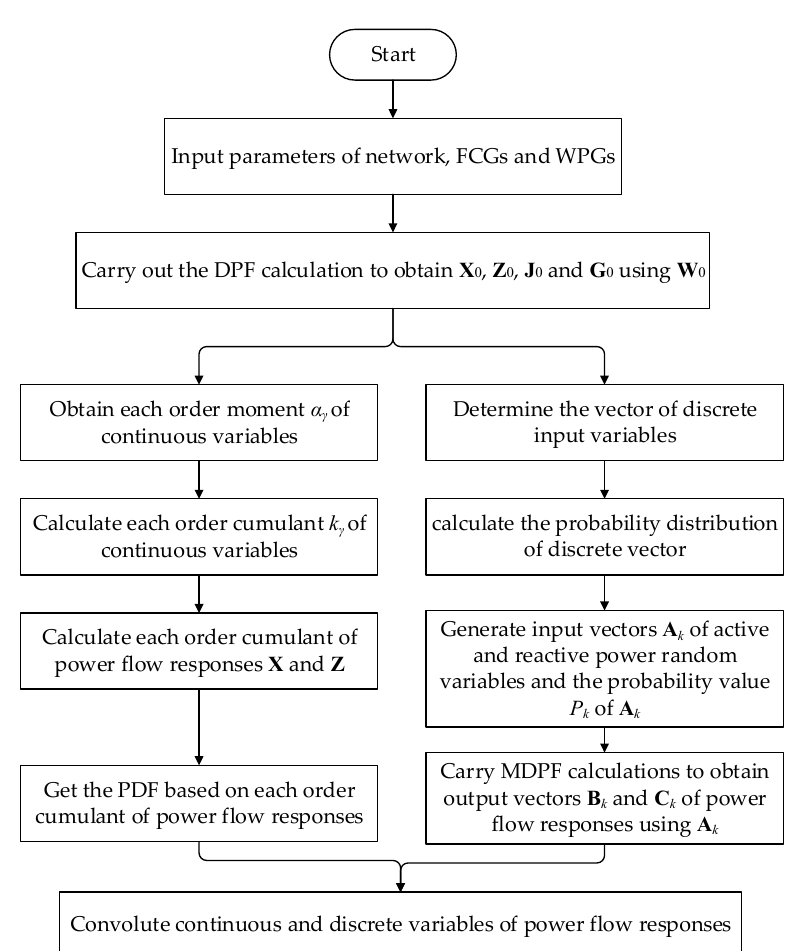
Figure 1. Flowchart of the power flow considering continuous and discrete variables (CDPF) method. DPF: deterministic power flow; FCG: fuel cell generator; PDF: probability density function; MDPF: multiple DPF; WPG: wind power generator.